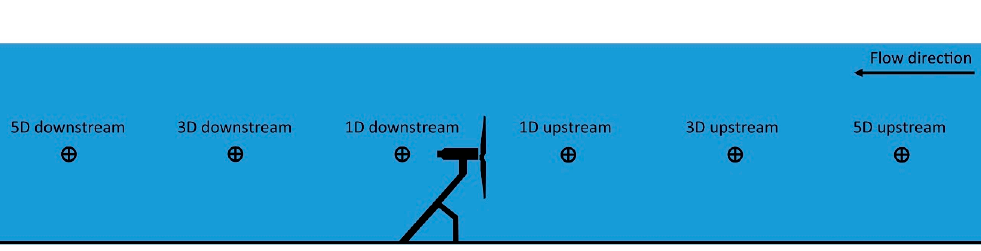
Figure 5. Upstream and downstream Acoustic Doppler velocimetry (ADV) measurement locations during wake tests.